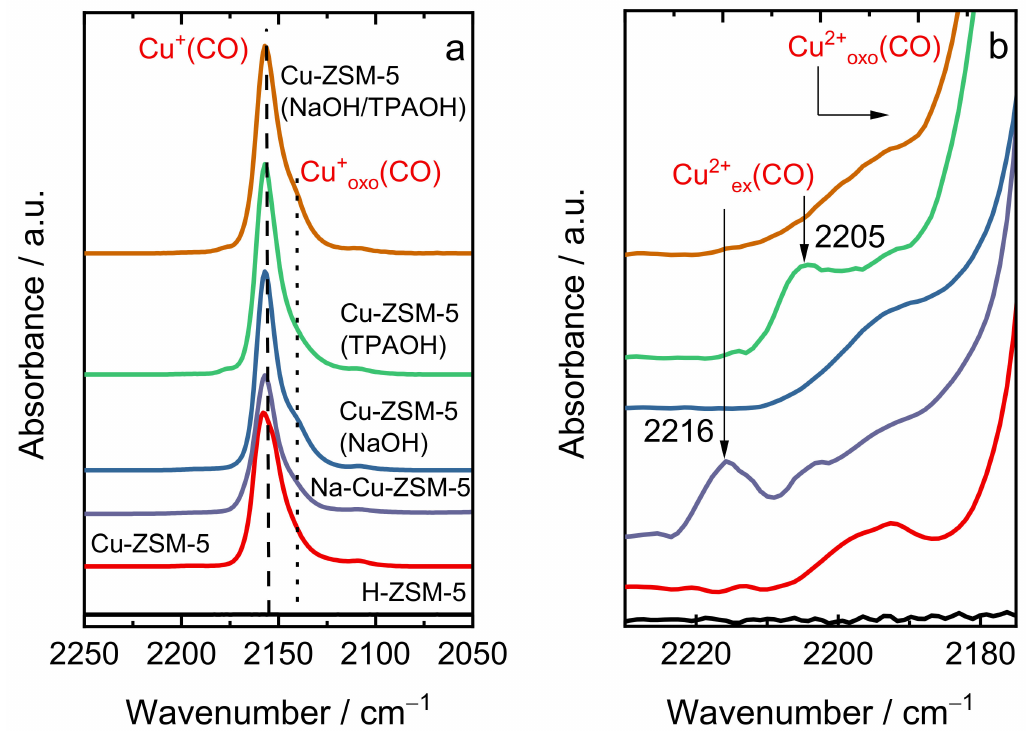
Figure 10. FT-IR transmission spectra of CO adsorbed at: ( a ) room temperature (RT) and ( b ) − 100 ◦ C in H-ZSM-5, micro- /mesoporous Cu-exchanged ZSM-5 and Cu-exchanged ZSM-5 with co-cation. The spectra present the maximum intensities of the copper (I) and copper (II) monocarbonyl bands. Table 6. Concentration of copper sites derived from quantitative IR studies of CO adsorption: concentration of monocar- bonyls ( C (Cu + exch ), C (Cu + oxo ), C (Cu 2+ exch+oxo )), and total concentration ( C Total ).